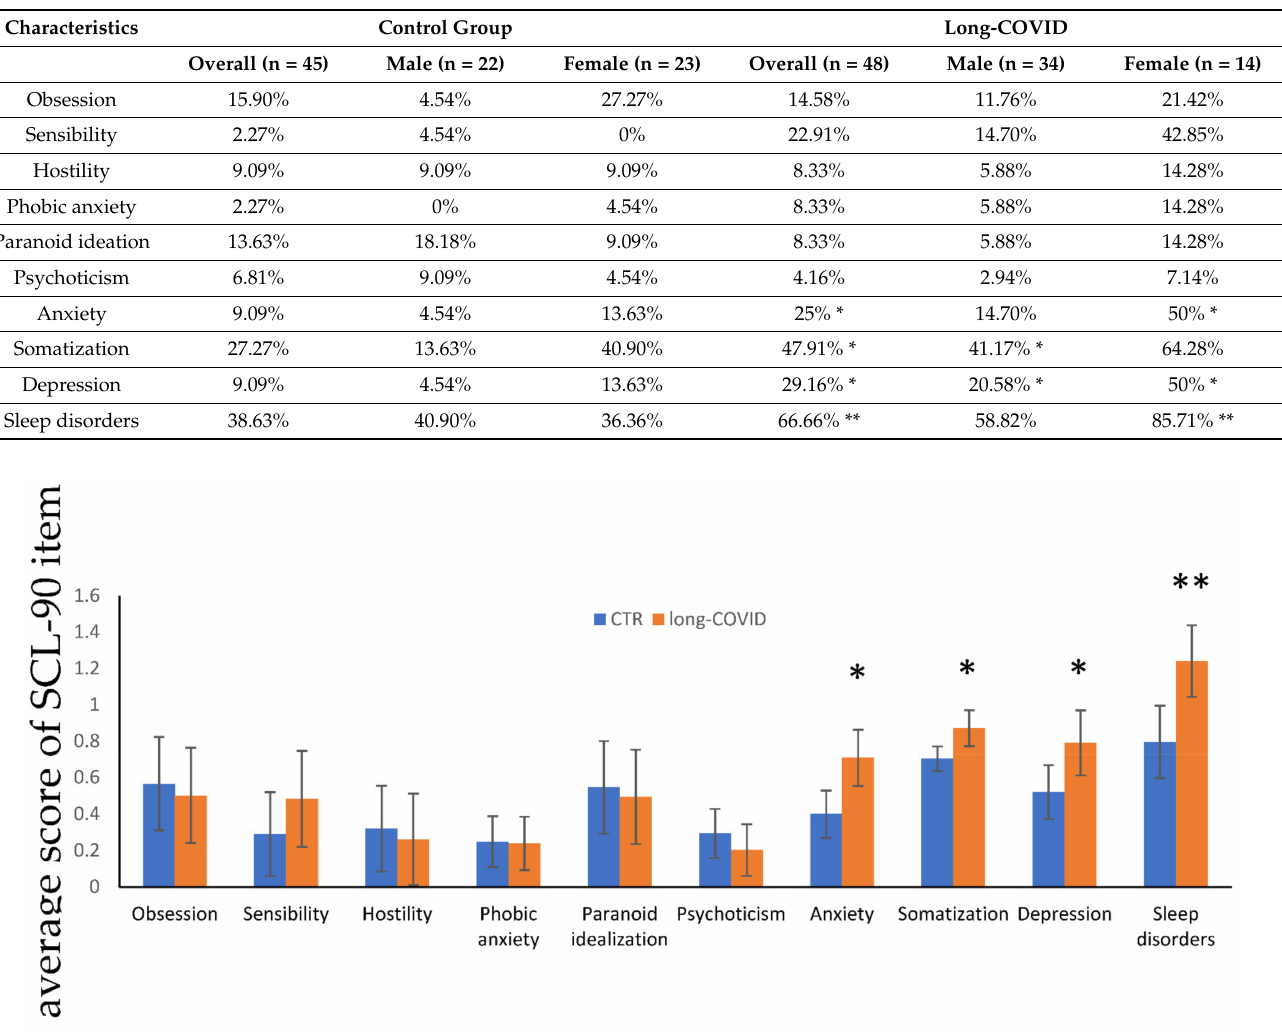
Table 2. Values are reported as percentage for the categorical variables. Statistical significance was